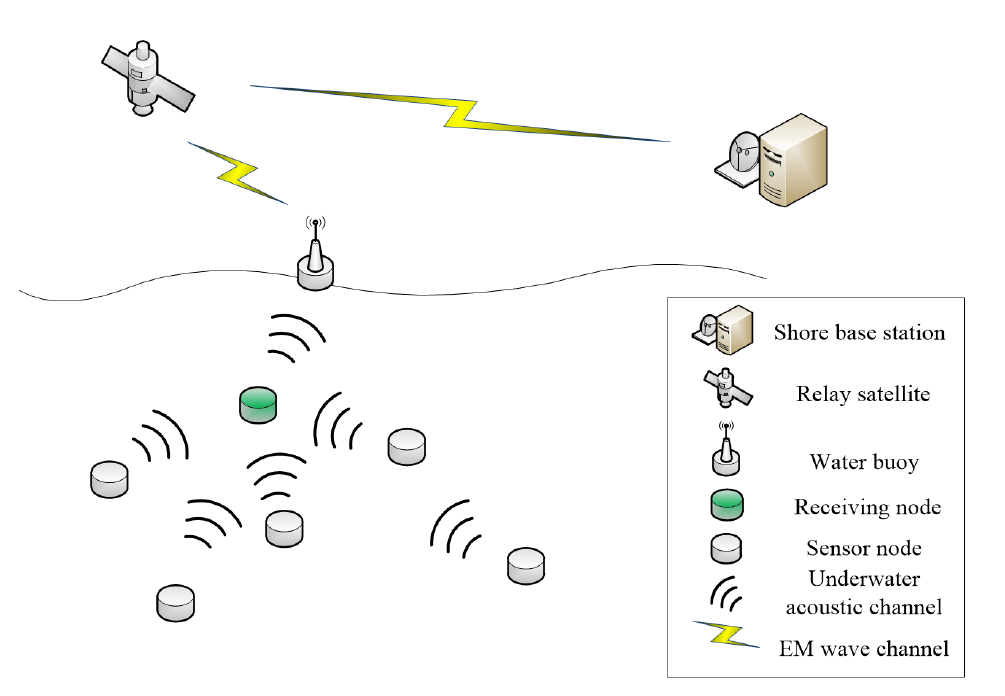
Figure 2. Network